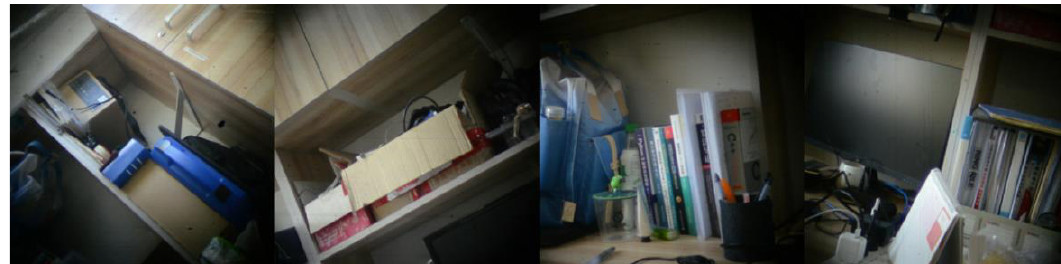
Figure 21. Sample images of scene 2.